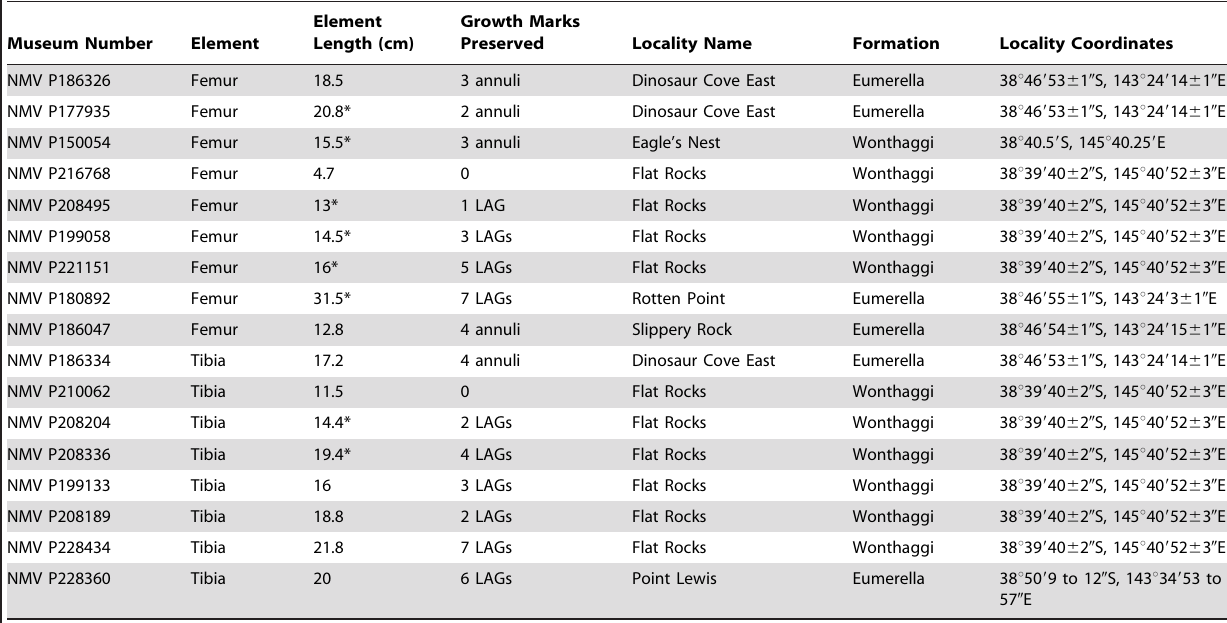
Table 1. Data for Australian polar dinosaur fossils included in this